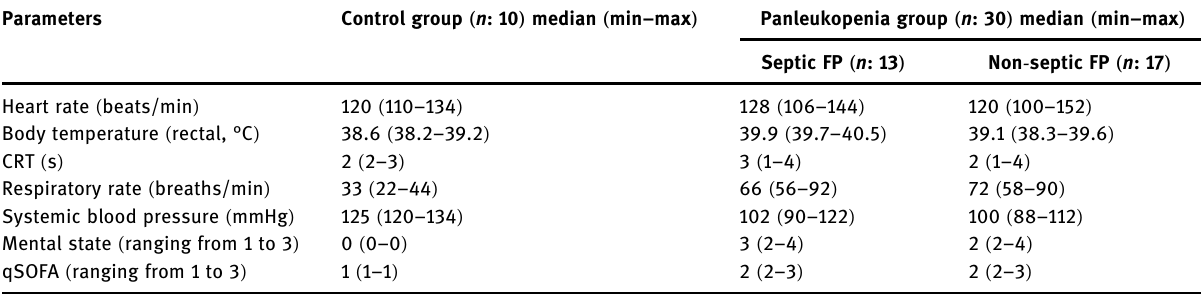
Table 1: Physical examination fi ndings and qSOFA scores